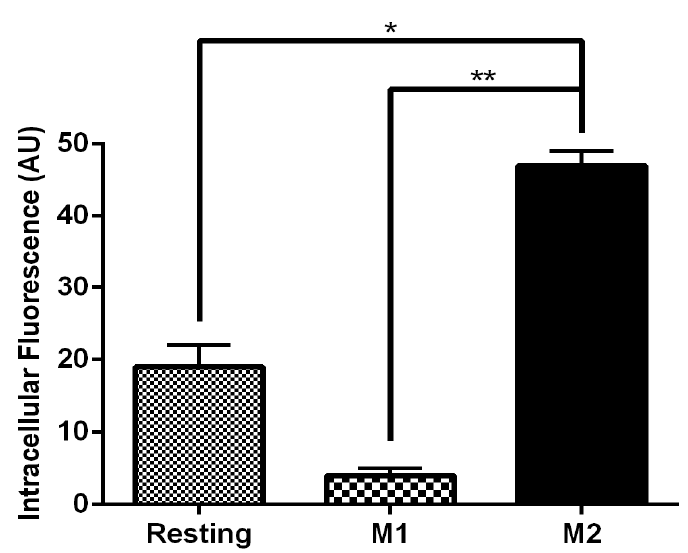
Figure 5. Uptake of FITC-labeled MRTL into M1 and M2 MPs. Free MRTL (120 nM) was incubated with macrophages for 1 hour at 37 °C. Cells were washed with PBS and acid wash solution and analyzed by confocal microscopy. Quantification of the uptake was performed with the confocal image analytical software. Compared to M1 MPs, uptake into resting MPs and M2 MPs was 2.4- and 11.8-fold greater, respectively (AU: arbitrary units of fluorescence of the confocal analytical software; *: t test p < 0.05; **: t test p < 0.01).